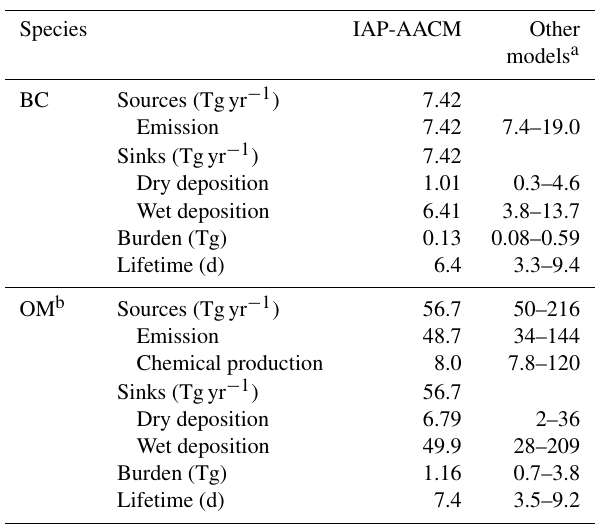
Table 5. Global budgets for carbonaceous aerosol.